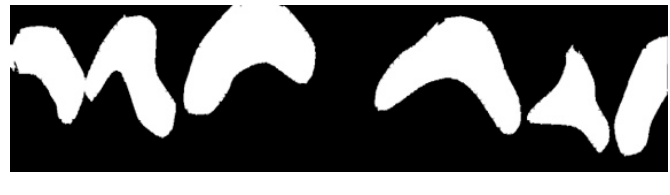
Figure 9. Shows the contours of the erosion area, extrapolated from the main image.